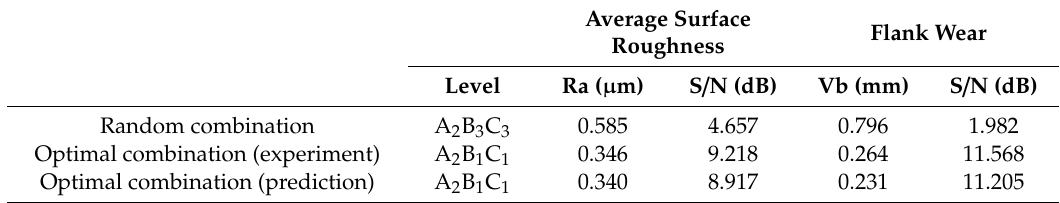
Table 9. Comparison of the Ra and